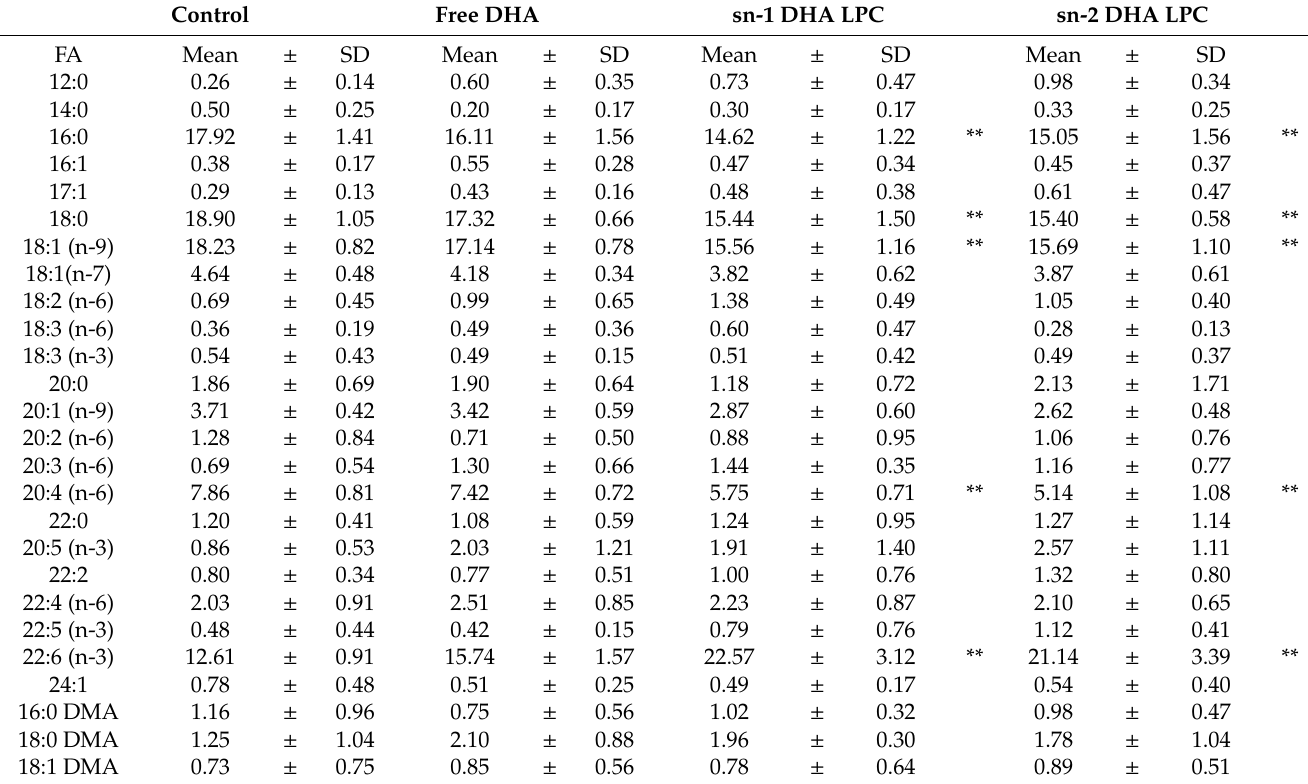
Table 2. E ff ect of free DHA, sn-1 DHA LPC, and sn-2 DHA LPC on fatty acid composition of mouse